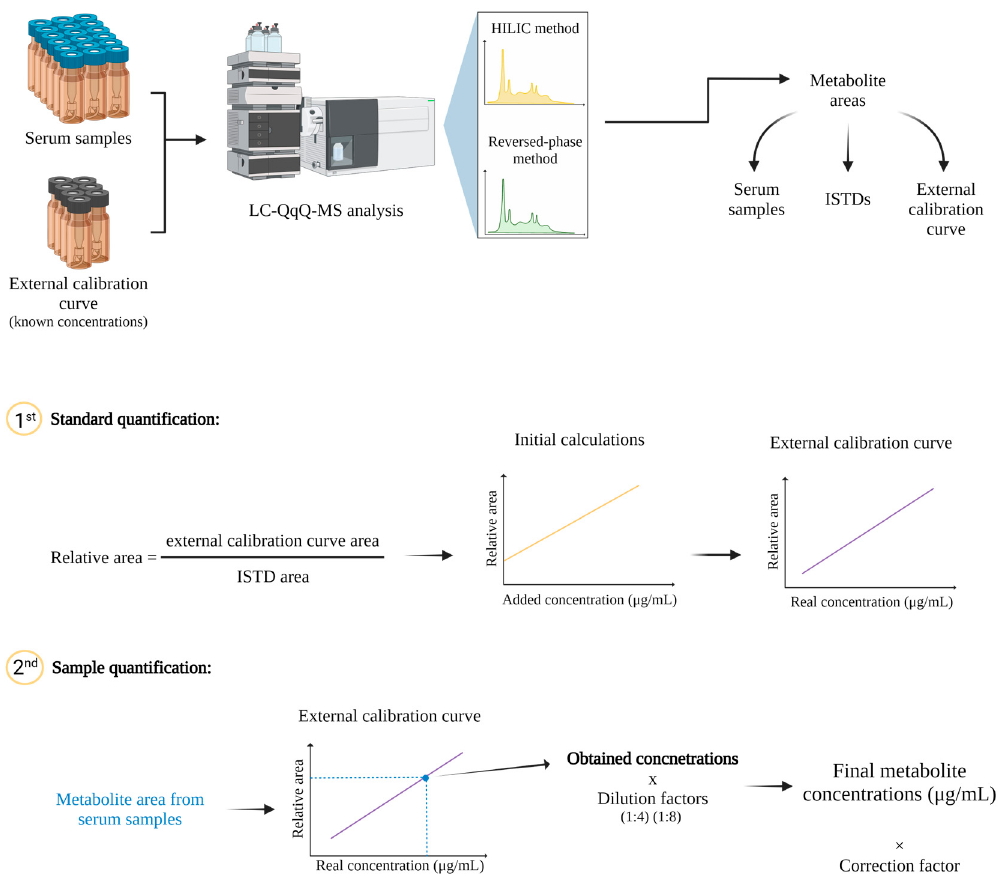
Figure 6. Diagram of metabolite quantification.